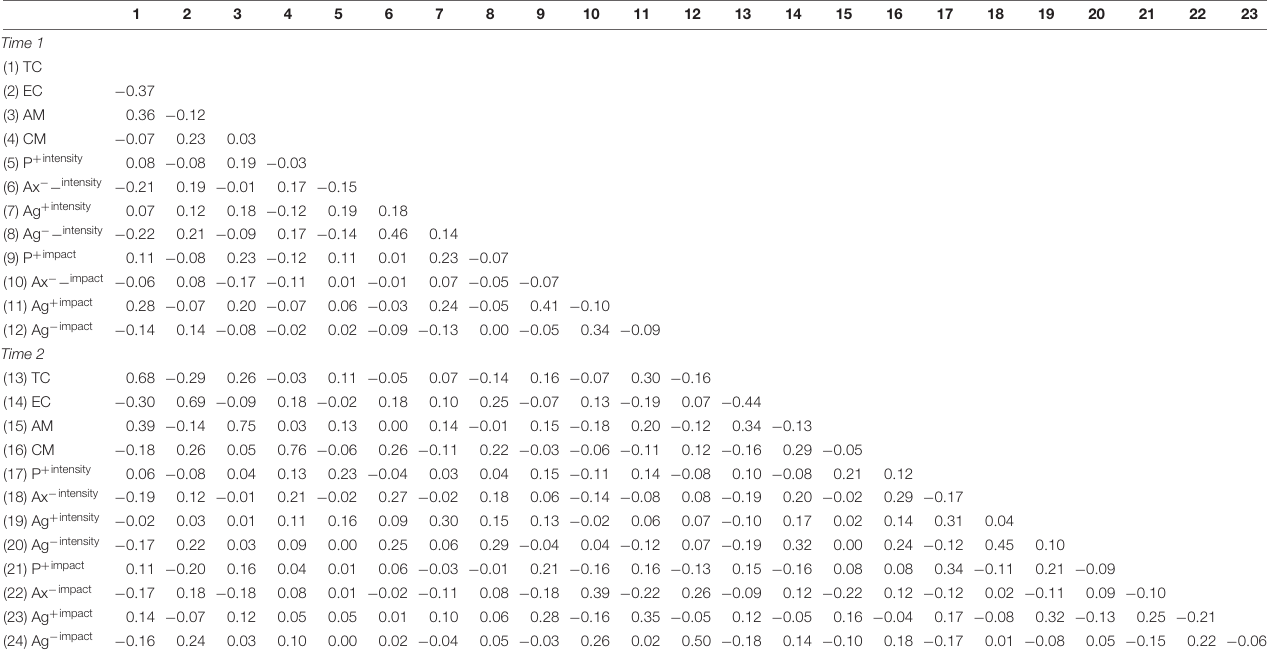
TABLE 2 | Bivariate correlations of the study variables in Time 1 and Time